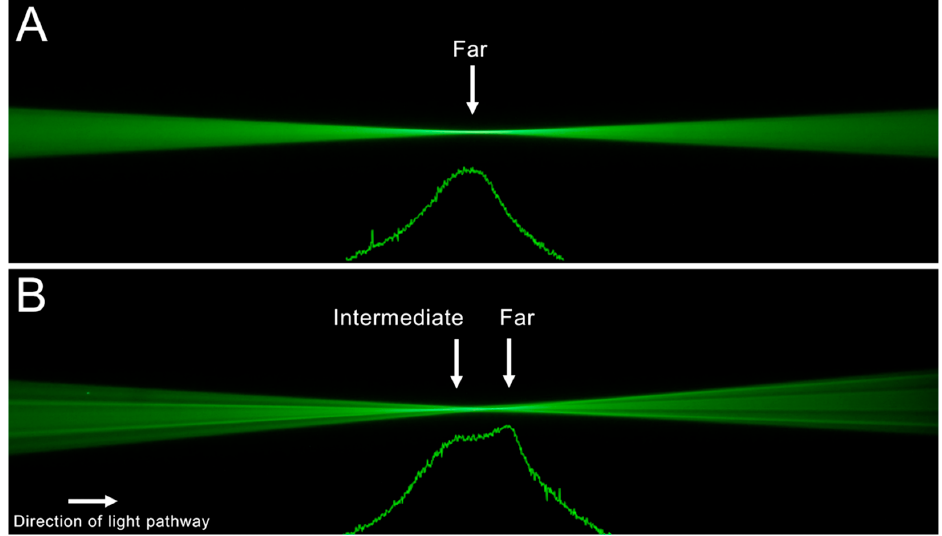
Figure 2. ( A ): Light-pathways visualization and light intensity profile of the monofocal control IOL SN60WF with one distinct focus. ( B ): Ray propagation and light intensity profile of the Acrysof IQ Vivity IOL with an elongated focus.